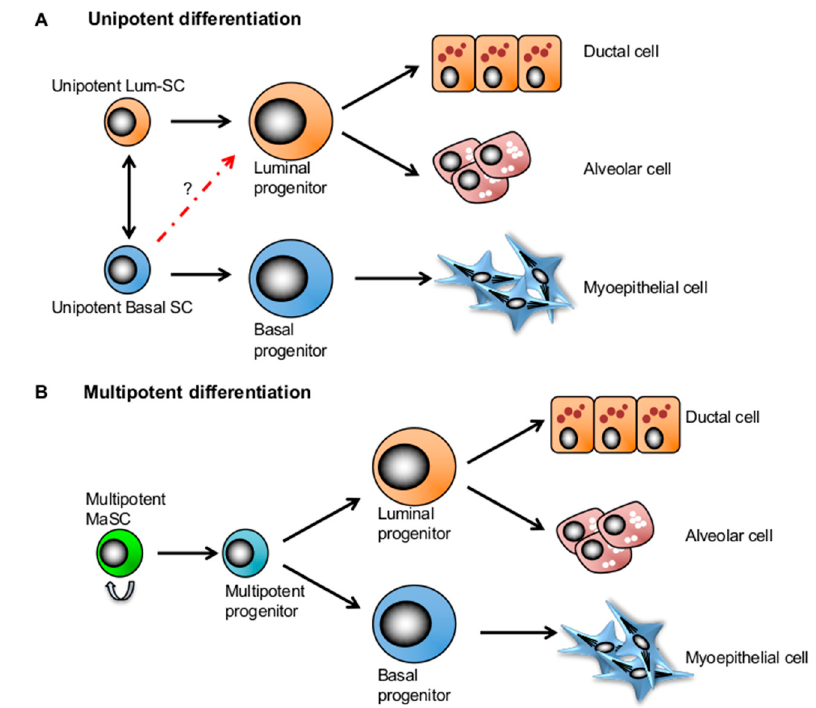
Figure 2. Two competing mammary stem cell (MaSC) models in mammary gland development. ( A ) The lineage-restricted unipotent MaSC model postulates that each compartment is maintained by its own unipotent stem cells in the adult mammary gland. ( B ) The bipotent MaSC model proposes that there exist a multipotent stem cell population that can give rise to all lineages of the mammary tissue. In support of the bipotent MaSCs in morphogenesis and adult gland maintenance, basal + + − Lin - CD29 hi CD24 and luminal Lin CD29 lo CD24 cell compartments, segregated by